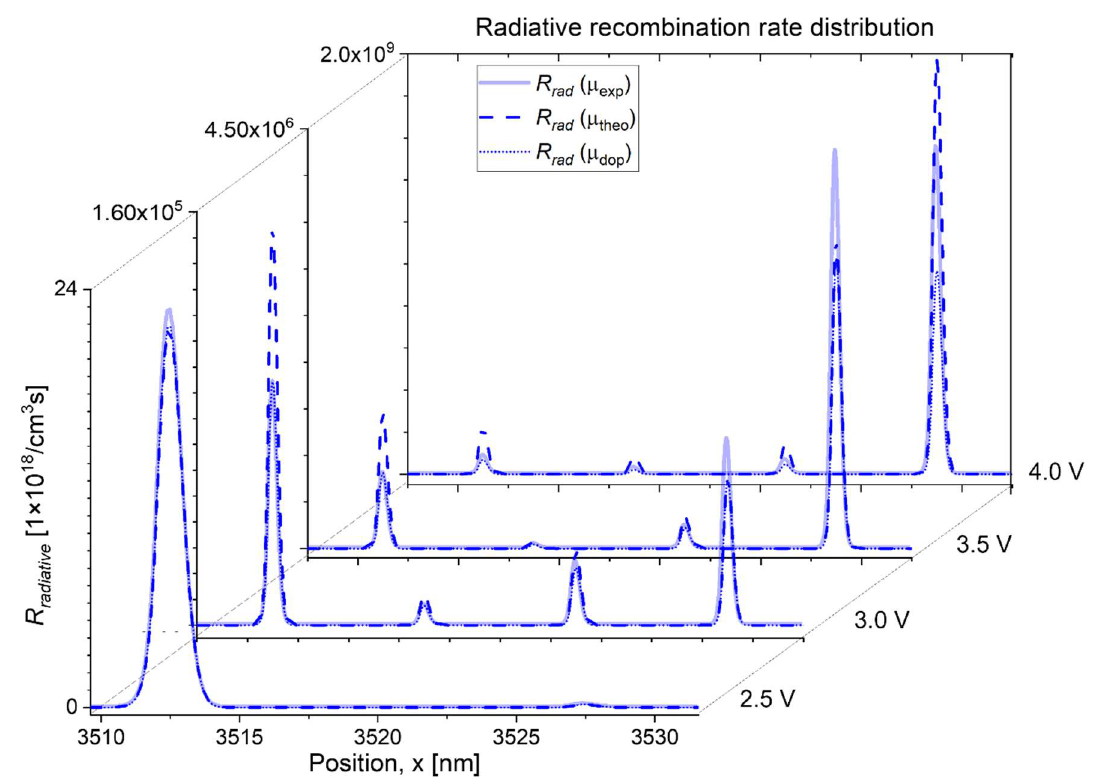
Figure 9. Spatial distribution of the radiative recombination rate for 2.5 V, 3.0 V, 3.5 V and 4.0 V voltage points of the LED.